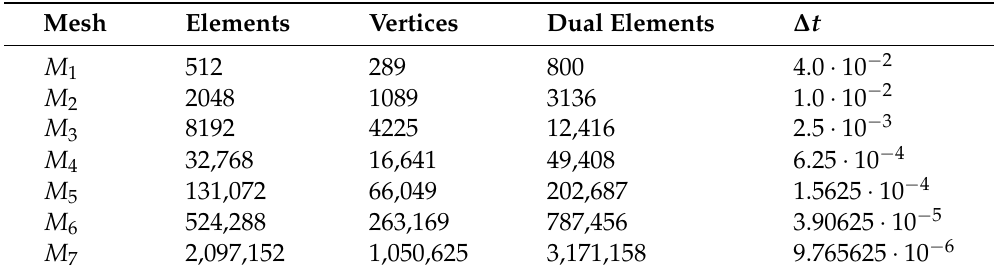
Table 1. Description of the meshes and time steps used to perform the convergence analysis in triangular primal grids.